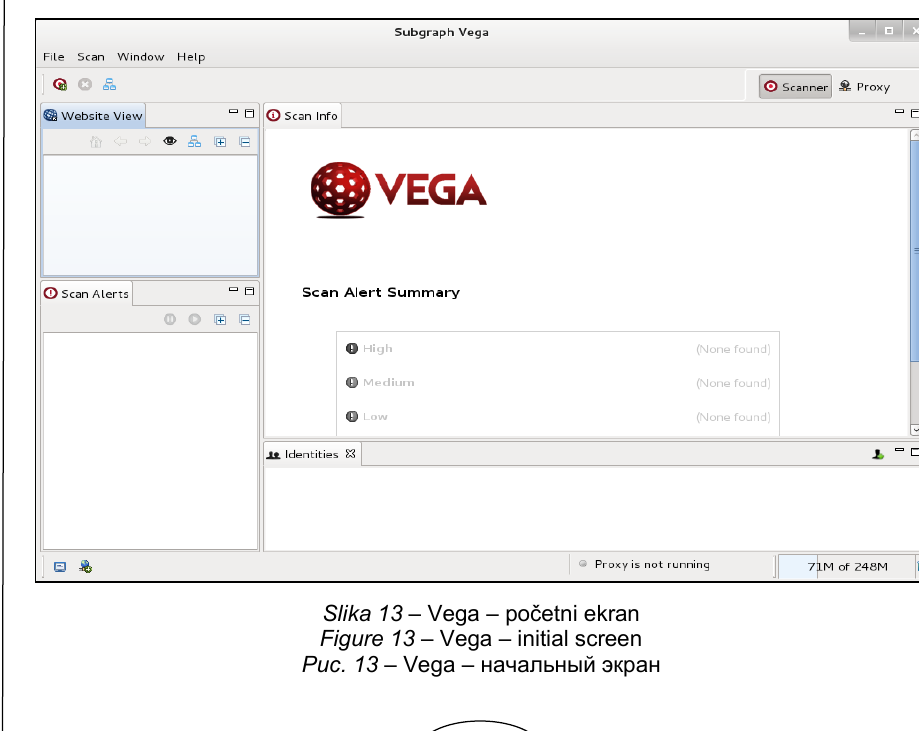
Figure 13 – Vega – initial screen Рис . 13 – Vega – начальный